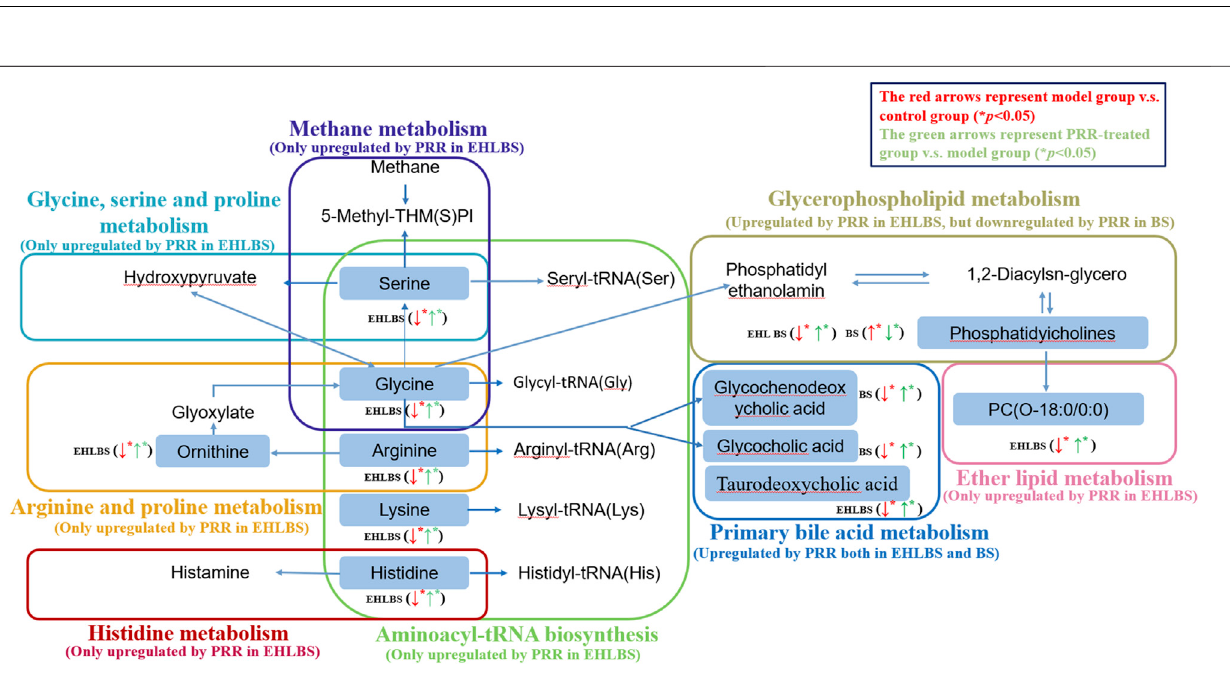
FIGURE7| MetabolicnetworksassociatedwiththepharmacodynamiceffectsofPRRintheEHLBSstageandBSstage.Eightdottedrectanglesindifferentcolors represented eight different pathways. Metabolites in the boxes were the endogenous metabolites PRR could regulate directly in this study. ↑ denoted up-regulation; ↓ denoted down-regulation.